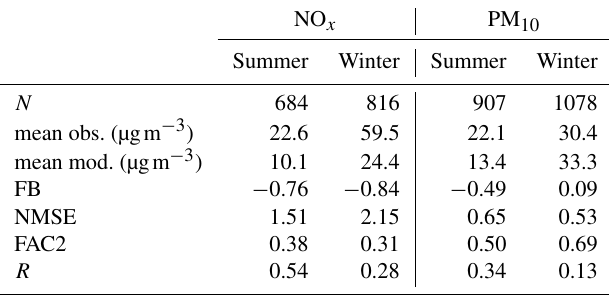
Table 1. Evaluation of CAMx 1h concentrations against urban background stations for the summer and winter